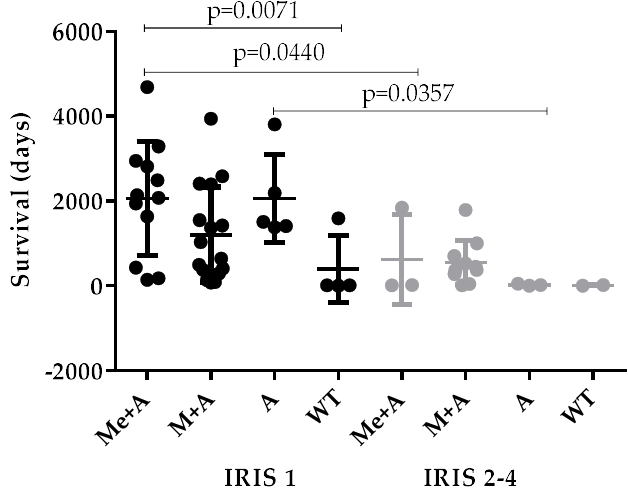
Figure 8. The survival time of patients according to the IRIS stage and therapeutic protocol. The survival time of patients showing normal renal function (classified as IRIS 1) or presenting renal dysfunction (IRIS 2, 3, and 4) treated with meglumine antimoniate plus allopurinol (Me + A), miltefosine plus allopurinol (M + A), allopurinol (A) or that did not receive treatment (WT) are represented by the mean and standard deviation. Statistical analysis was performed using the nonparametric Mann–Whitney test. Statistically significant differences are indicated by capped lines ( p < 0.05). Only events (death) were considered.